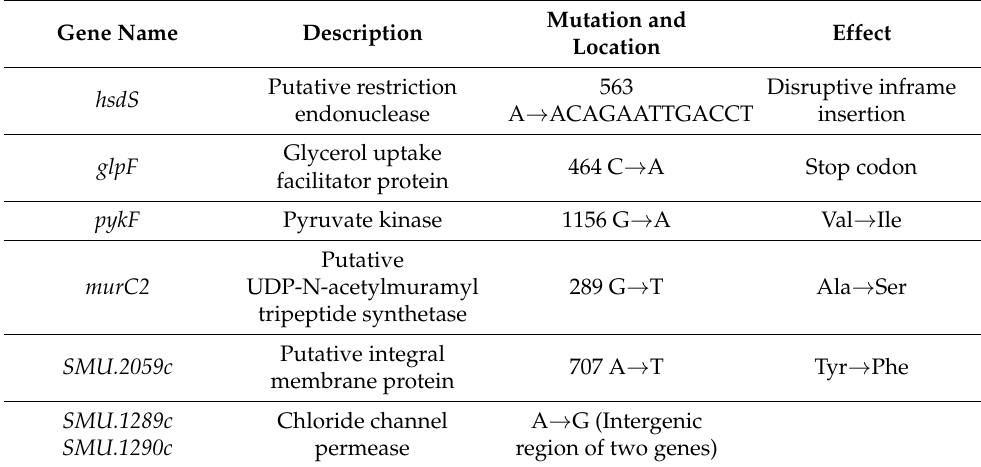
Table 1. List of genes harboring a mutation in the FR strain.